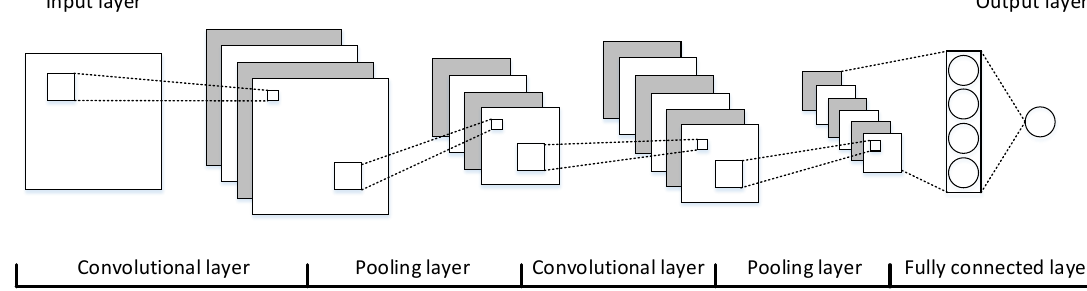
Figure 7. The structure of a